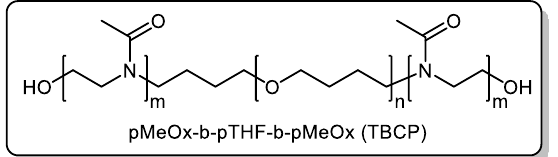
Figure 7. The chemical structure of TBCP triblock copolymer.